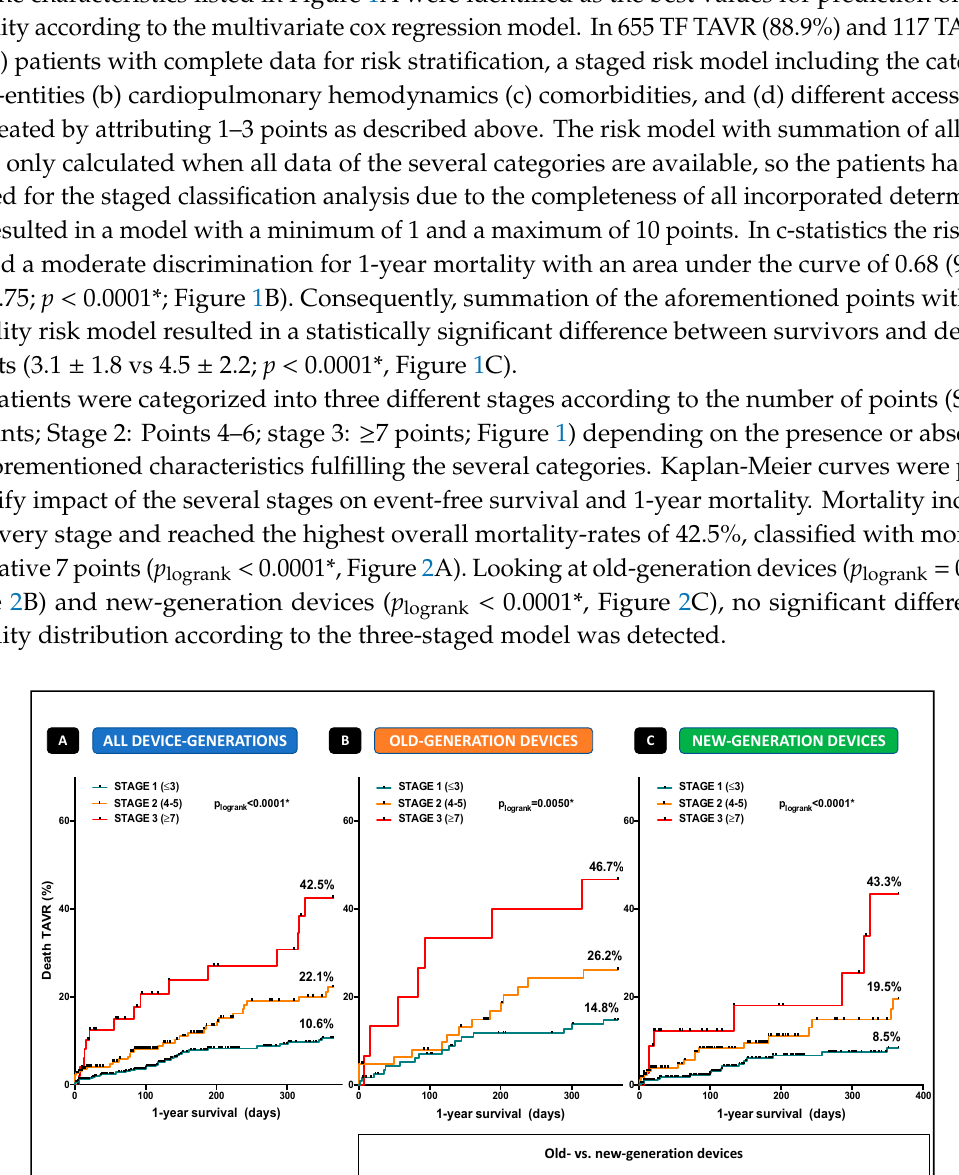
Table 2. Details of staged mortality risk models. 1-Year Mortality